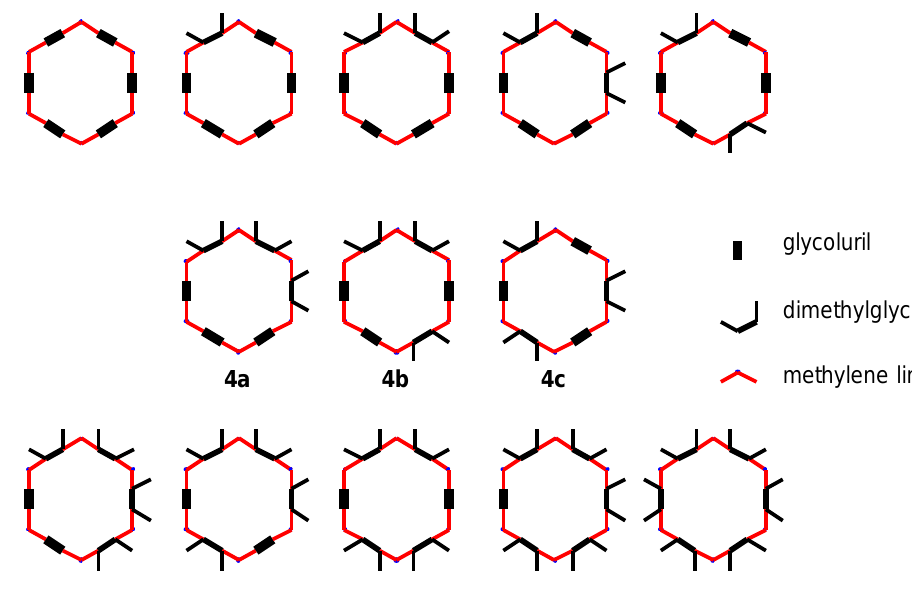
Figure 3. A pictorial representation of the possible substitution patterns to be found in Me u = 6 and s = 0 to 6 and u = 0 to